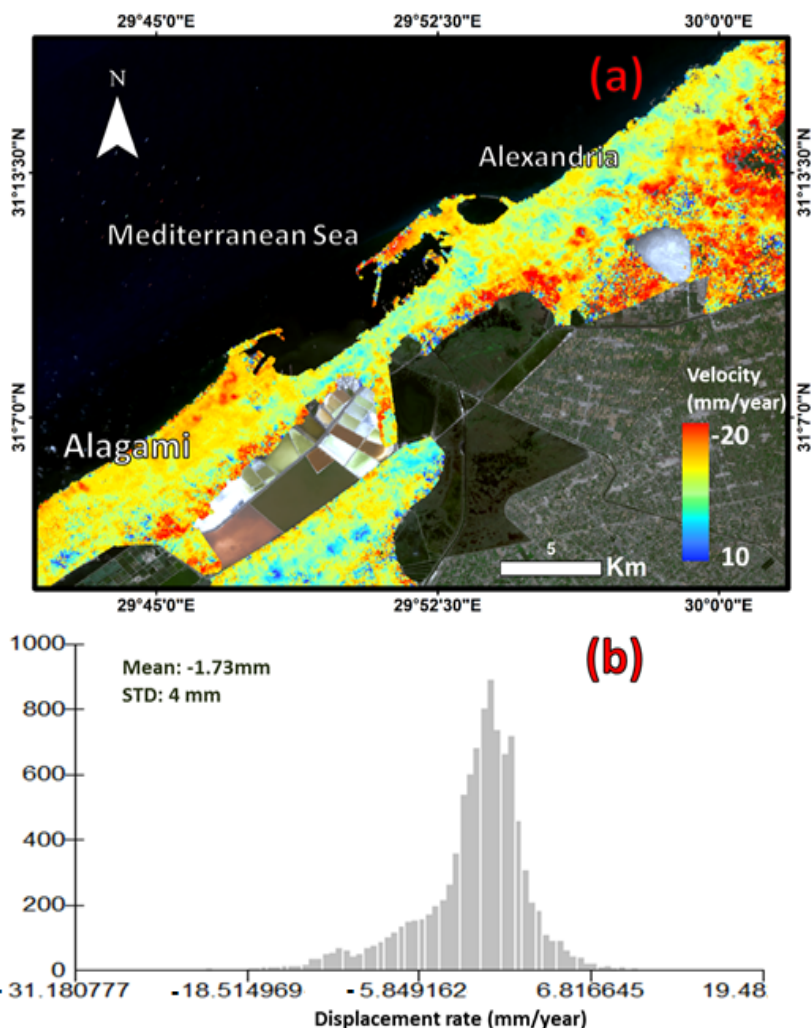
Figure 14. ( a ) The estimated mean displacement velocity of Alexandria and Alagami Cities using the Sentinel-1 data from August 2017 to September 2020 with coherence threshold of 0.4; ( b ) the corresponding histogram distribution of the derived displacement velocity rates.